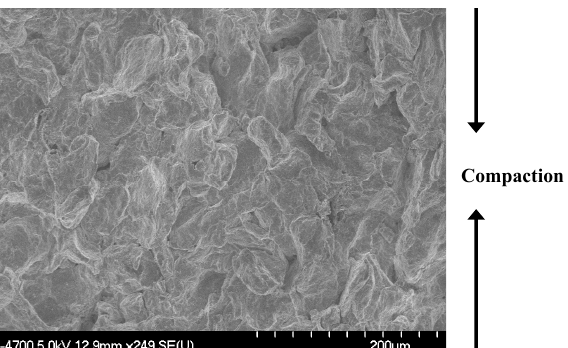
Figure 8. Low magnification SEM micrograph of P/M AZ31 alloy sintered at 500 °C (500 MPa, 20 min, 450 °C).